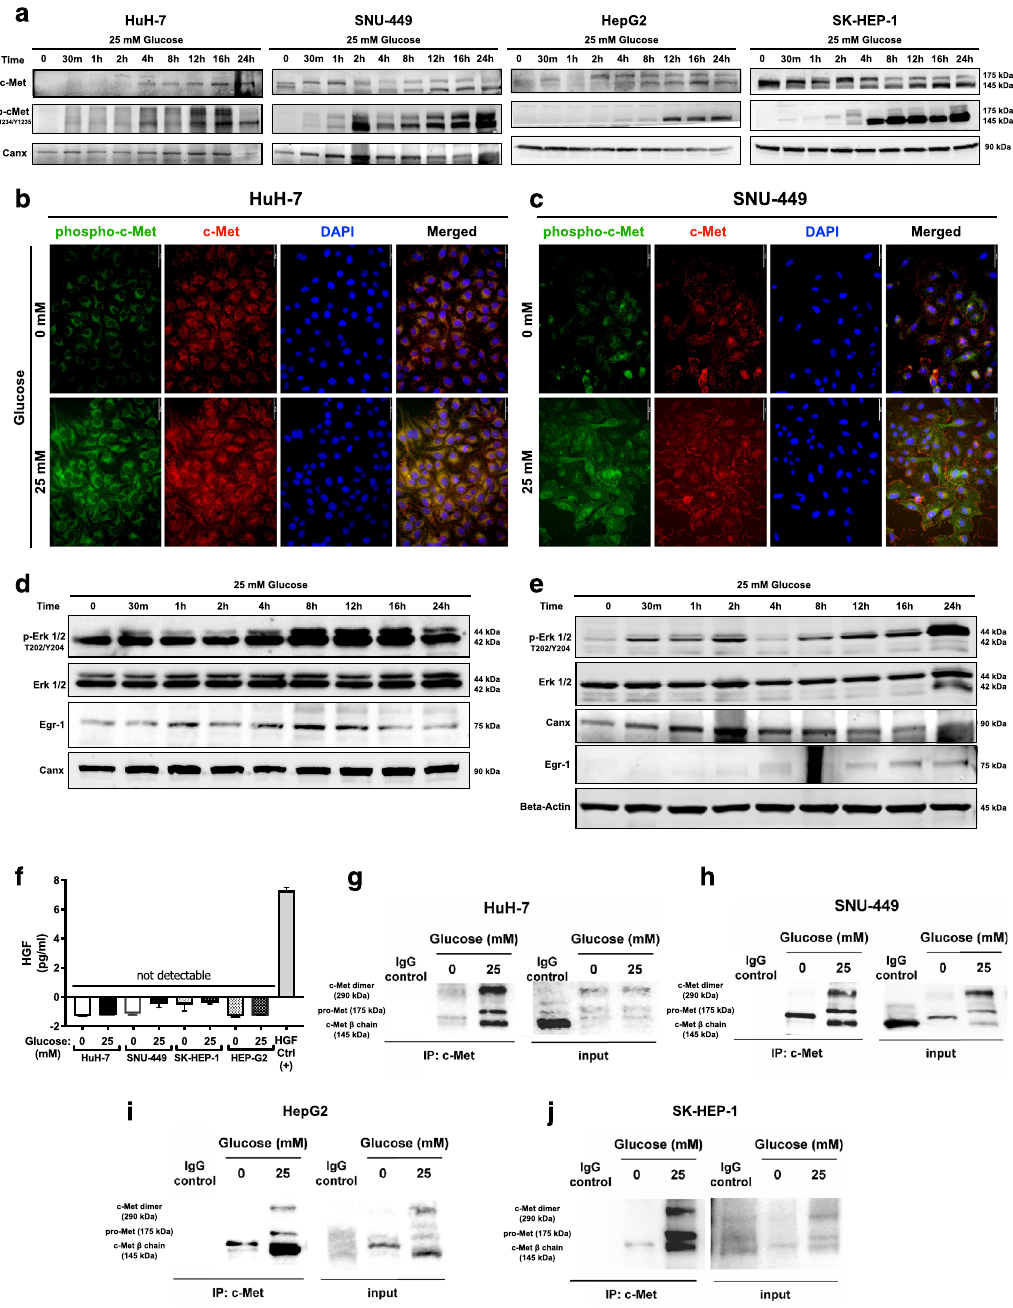
Figure 3. High glucose exposure activated c-Met and downstream signaling via promoting ligand-independent homodimerization. ( a ) Immunoblotting of time-dependent c-Met protein expression and activation phosphorylations (Y1234/Y1235) in response to high glucose treatment in HuH-7, HepG2, SNU-449, and SK-HEP-1 cells. Immunofluorescence imaging of Alexa-594-labeled c-Met protein and Alexa-488 labeled c-Met activation phosphorylations (Y1234/Y1235) in response to no- and high-glucose (25 mM) conditions in ( b ) HuH-7 and ( c ) SNU-499 cells. Cell nuclei were counterstained with DAPI staining. Immunoblotting of time-dependent expressions of Erk1/2 activation phosphorylations (T202/Y204), Erk1/2 total protein and Egr-1 protein in response to high glucose stimulation in ( d ) HuH-7 and ( e ) SNU-449 cells. Calnexin (Canx) immunoblotting performed as an internal control. ( f ) Graphical presentation of HGF secretion analysis with ELISA. Conditioned media of HCC cells cultured in no- and high-glucose supplemented conditions were analyzed with sandwich ELISA. Crosslinking- immunoprecipitation assay for analyzing c-Met homodimerization under no- and high-glucose (25 mM) conditions in ( g ) HuH-7, ( h ) SNU-449, ( i ) HepG2 and ( j ) SK-HEP-1 cells. After starvation and indicated treatments for 16 h, proteins were crosslinked with Sulfo-EGS, c-Met was immunoprecipitated and immunoblotted with c-Met targeting primary antibody. Full length blots are presented in Supplementary. Column graph was generated using GraphPad Prism version 8.2.1 for MacOS, GraphPad Software, San Diego, California USA, https:// www. graph pad.